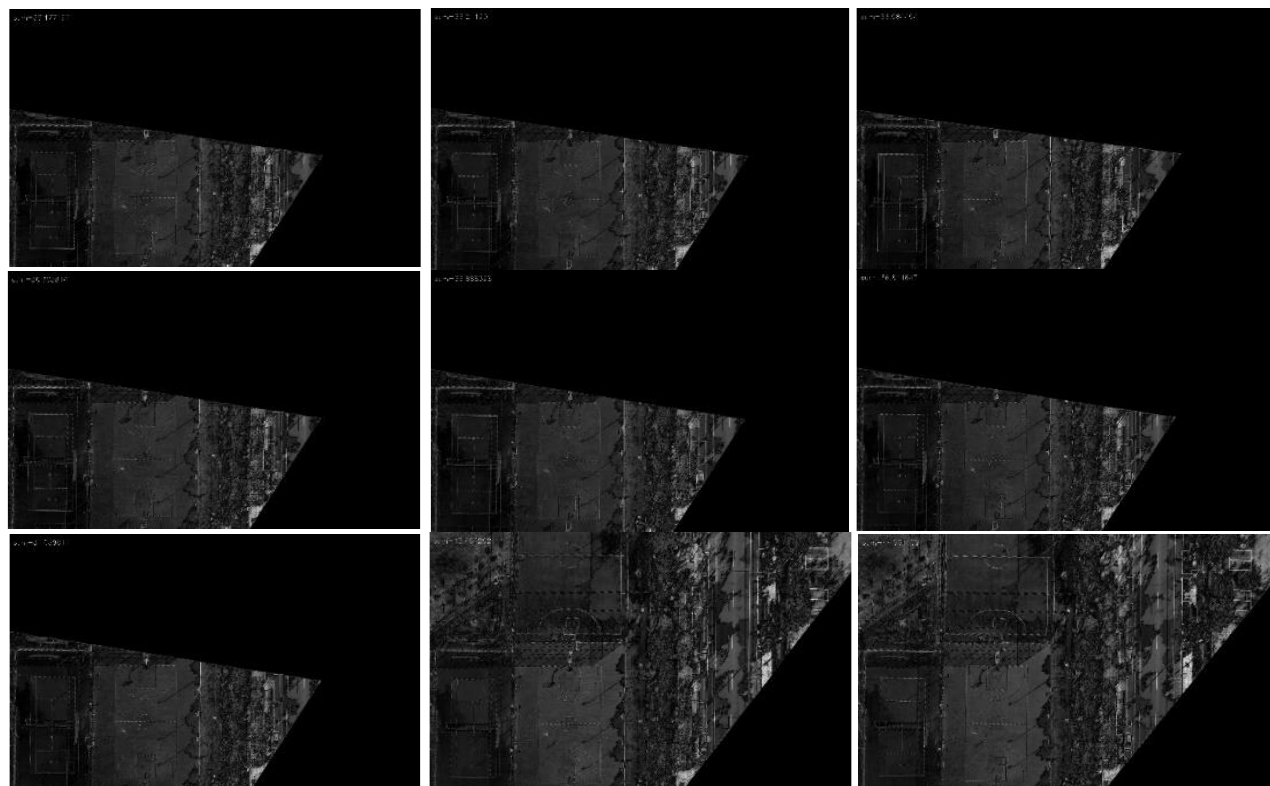
Figure 17. Registration difference image (without updating the map features).